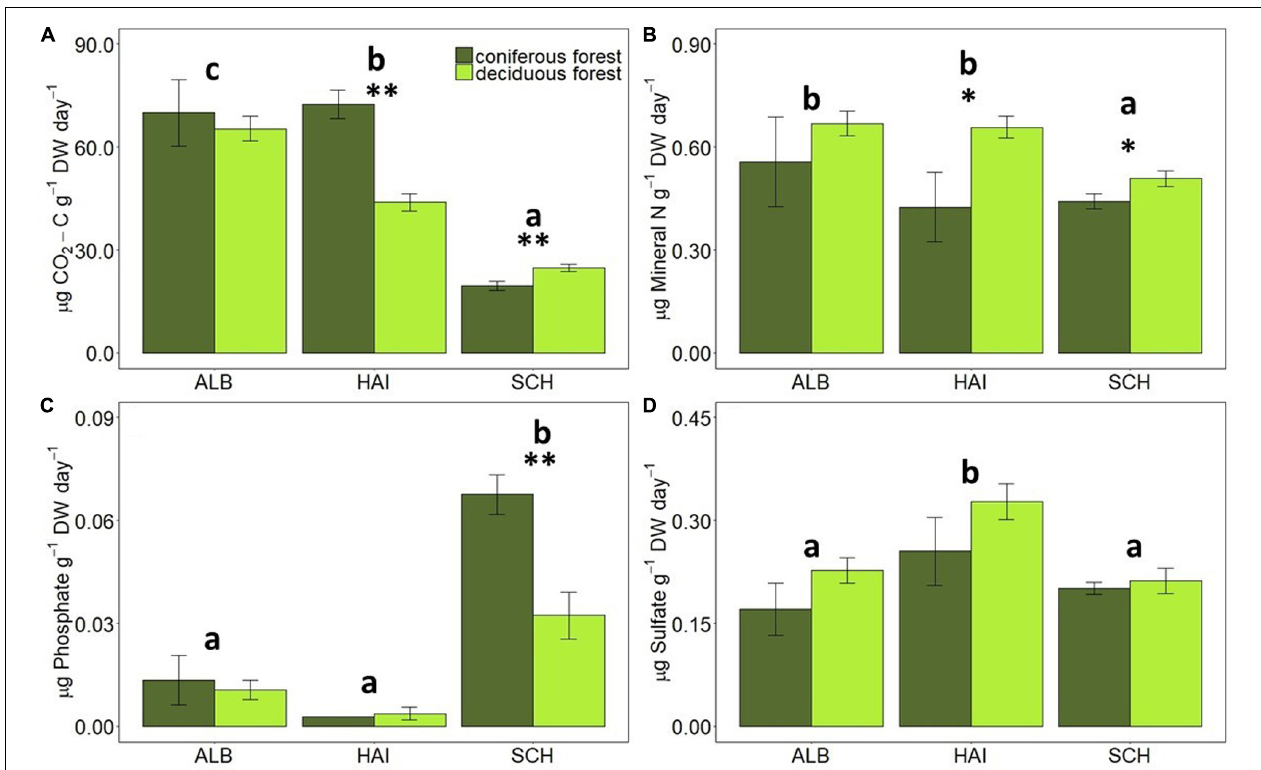
FIGURE 2 | Comparison of average mineralization rates of (A) C, (B) N, (C) P, and (D) S in different study regions and forest types. Error bars represent SE of means. X -axis represents study regions where ALB, Schwäbische-Alb; HAI, Hainich-Dün; SCH, Schorfheide-Chorin. Significant differences of variance between study regions are denoted by small letters, and between coniferous and deciduous forests by ∗ P < 0.05 and ∗∗ P < 0.01. Number of study sites included: ALB (deciduous forests, n = 38 and coniferous forest, n = 12), HAI (deciduous forests, n = 46 and coniferous forest, n = 4) and SCH: (deciduous forests, n = 28 and coniferous forest, n =